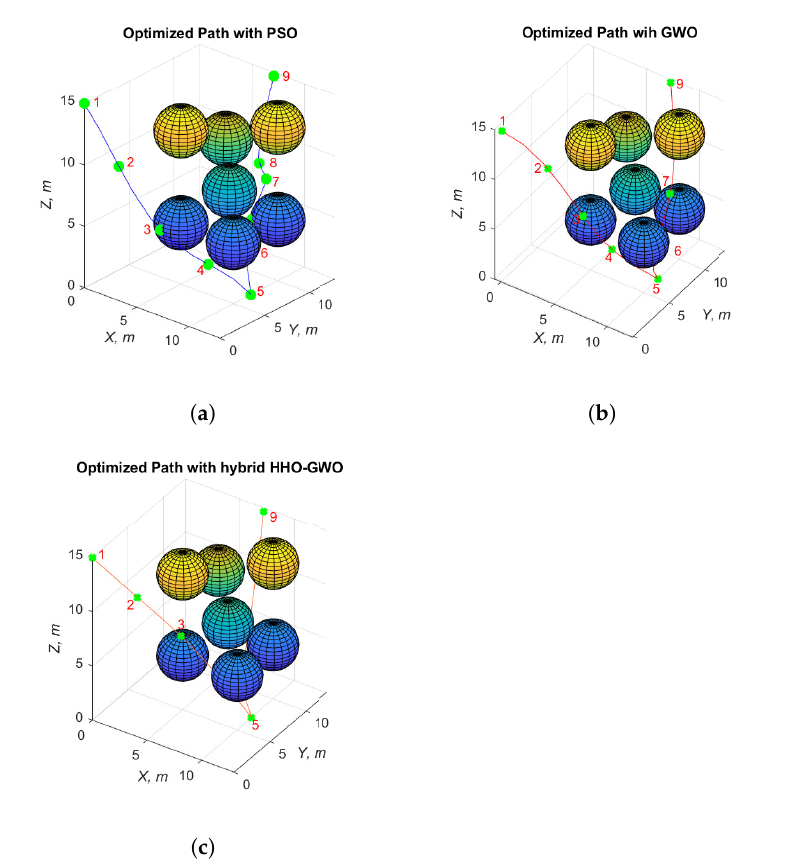
Figure 7. The optimized path for Map 1 ( a ) using PSO, ( b ) using GWO, and ( c ) using hybrid HHO–GWO.